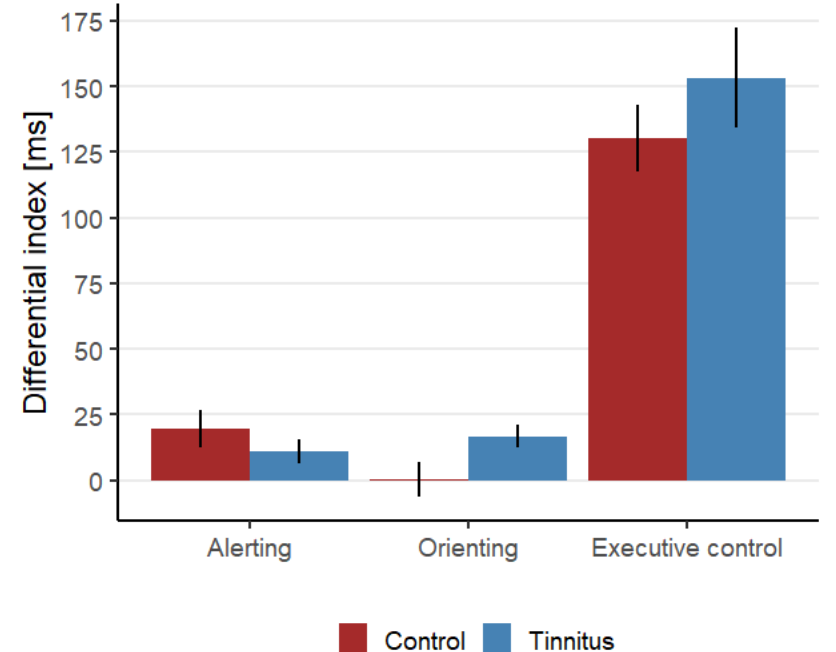
Figure 4. The differential indexes calculated based on RTs for the alerting (RT No Cue —RT Double Cue ), orienting (RT Central Cue —RT Spatial Cue ) and executive control (RT Incongruent —RT Congruent ) attention networks for both the control group and the tinnitus group at baseline. Error bars represent standard errors of the mean.